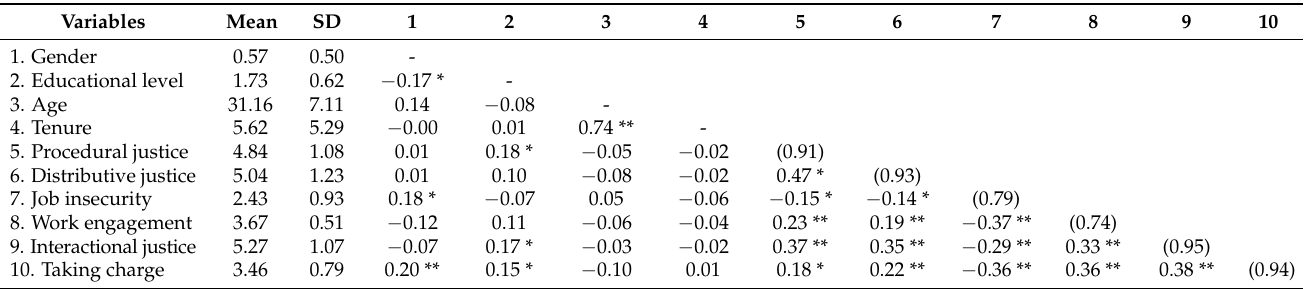
Table 1. Descriptive statistics and correlations of